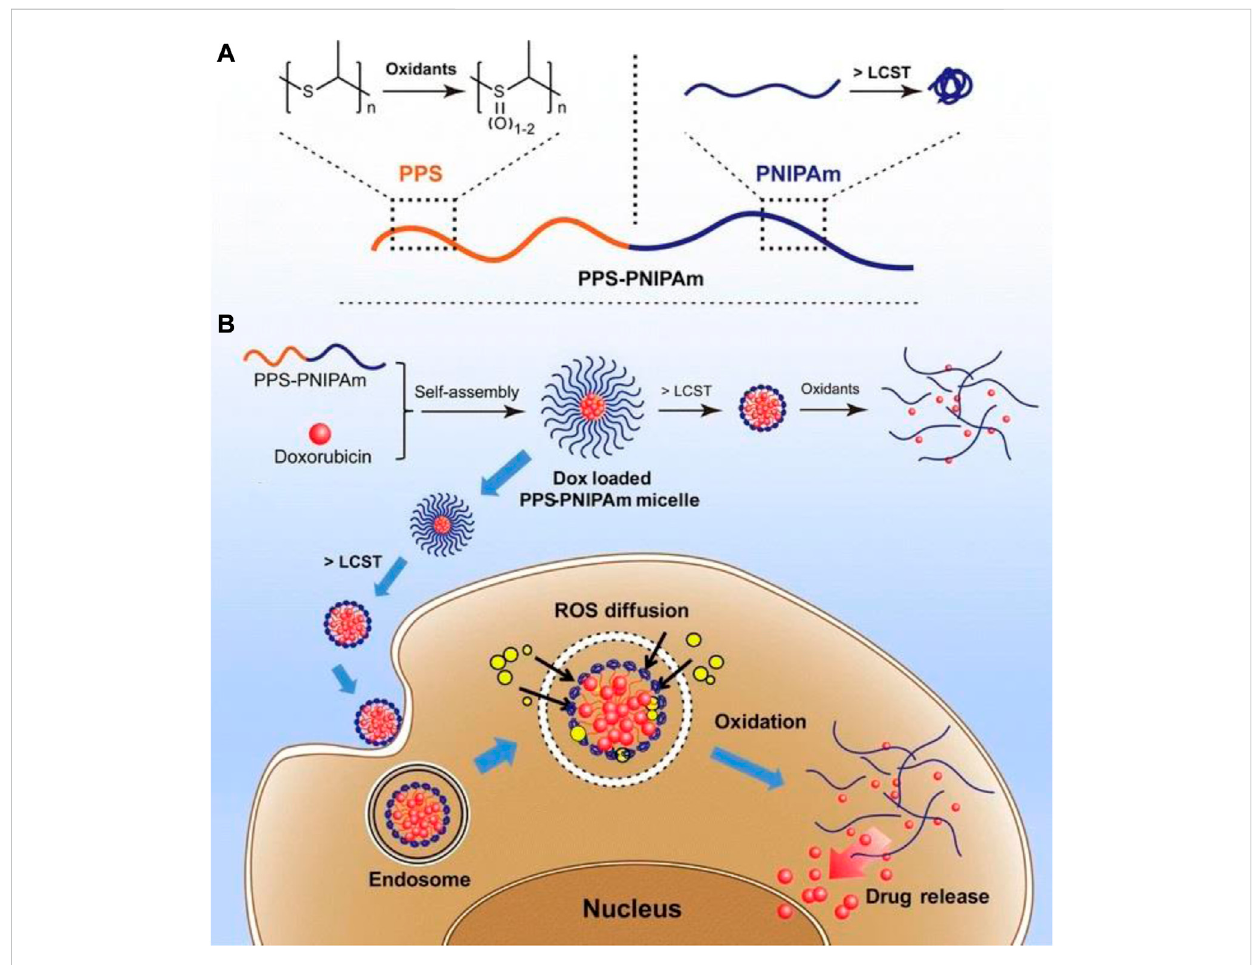
FIGURE 7 Representation ofthestimuli-responseoftheblockcopolymer PPS-PNIPAm. (A) ThePPSblock ’ soxidation responsivenessandthePNIPAm block ’ s temperature responsiveness. (B) Self-assembly of PPS-PNIPAm micelles and doxorubicin loading. To further oxidize and liberate enclosed DOX molecules, the PNIPAm corona must fi rst collapse and shrink over its LCST and PPS core. This type of drug-loaded nanocarrier can be exploited for cancer cell transport and drug release in an intracellular ROS environment (Tang et al.,